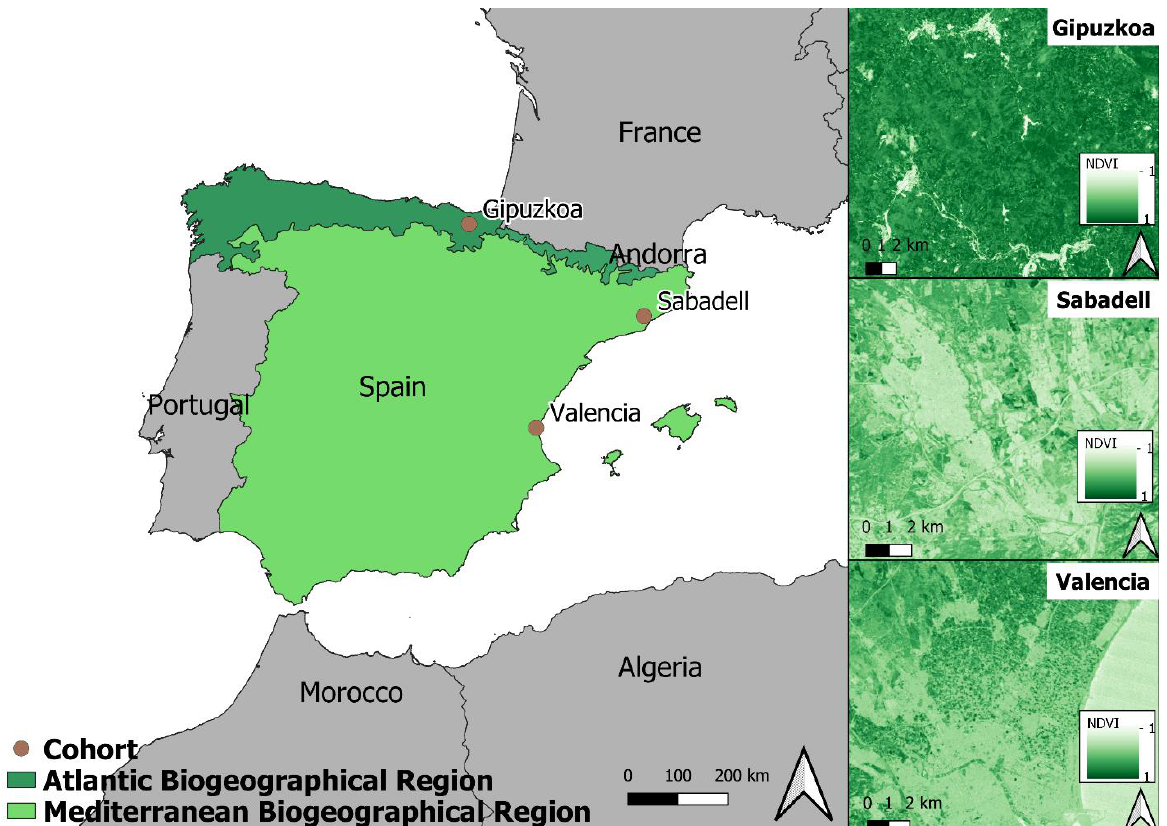
Figure 1. NDVI maps and biogeographic regions of the three INMA sub-cohorts, Gipuzkoa, Sabadell and Valencia, 2003–2008.